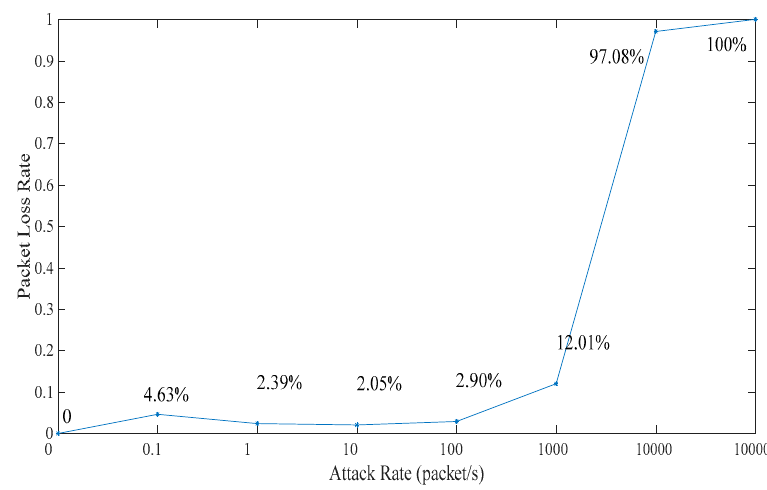
Figure 11. Test packet loss rate under different DoS attack rates.